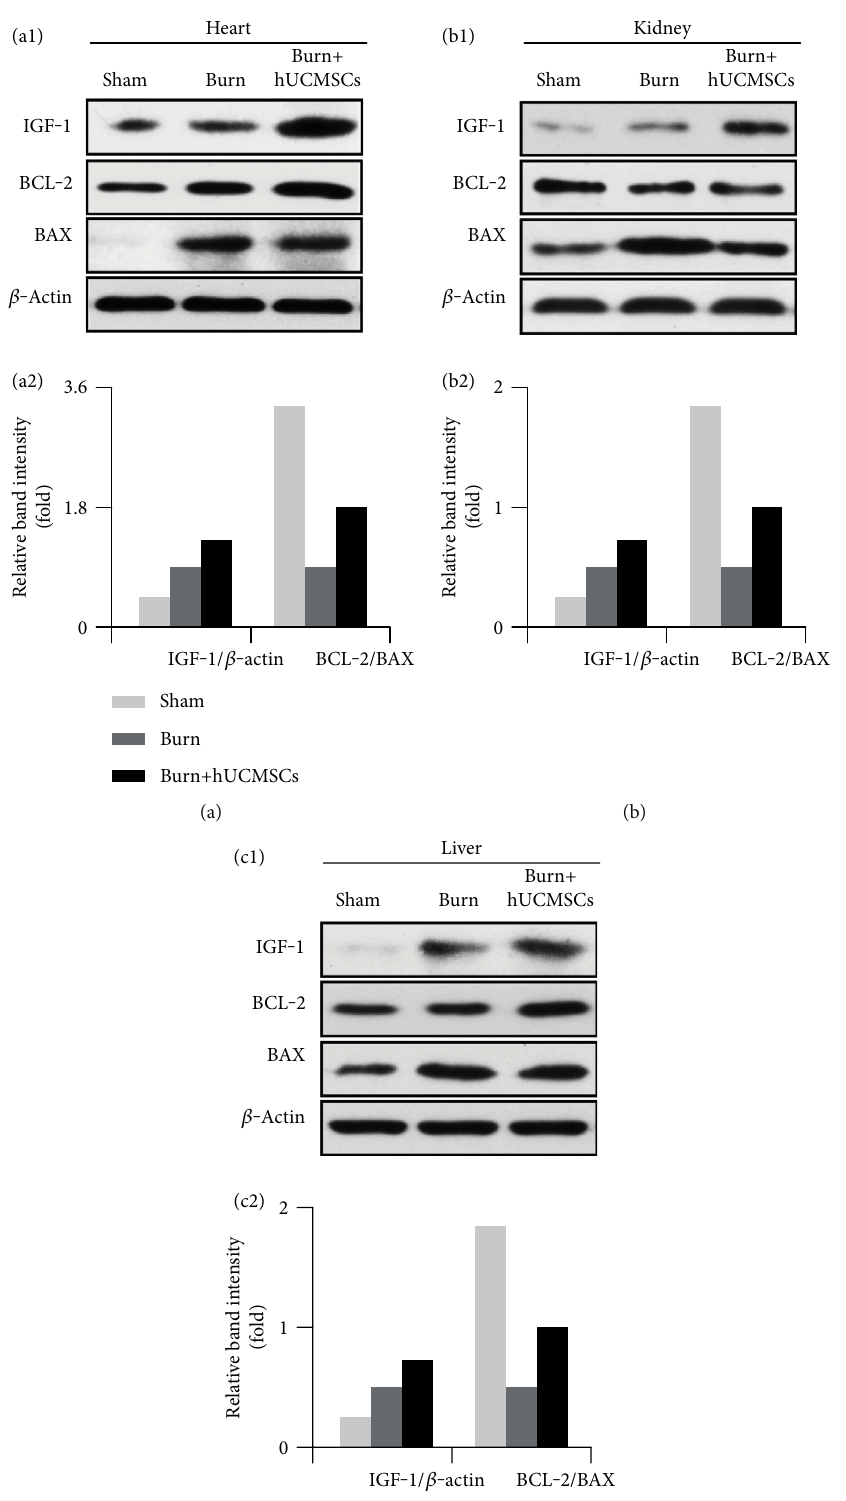
Figure 5: The hUCMSC administrations signi fi cantly increased protective cytokine IGF levels and BCL-2/BAX ratios. (a1 – c1) IGF-1 levels of the heart, kidney, and liver in the burn+hUCMSC groups were signi fi cantly higher than those in the burn groups, and they in the burn group were higher than those in the sham group. BCL-2/BAX ratios of the heart, kidney, and liver in the burn groups were markedly lower than those in the sham groups, while they in the burn+hUCMSC groups were signi fi cantly higher than those in the burn groups. (a2 – c2) The results of the quantitative analysis were presented in the corresponding